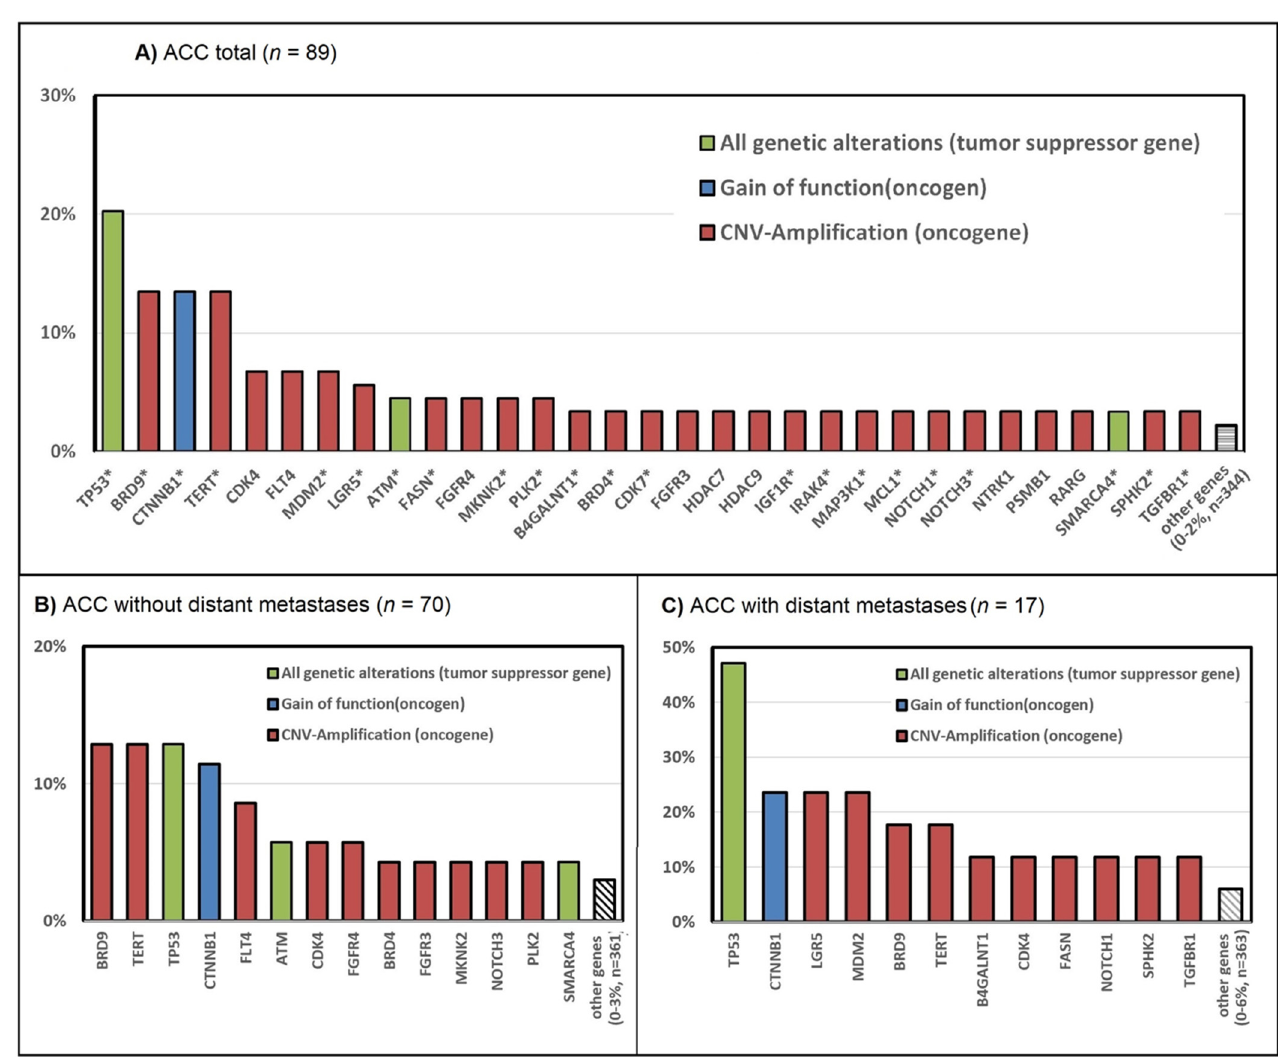
Figure 2. Target genes with FDA-approved drugs and drugs in clinical trials ( A ) depicts genetic alterations of TCGA (x-axis), which are targeted by FDA-approved drugs or drugs currently being tested in clinical trials (*). On the y axis, the frequency of these alterations can be read. Gain-of- function alterations are depicted in blue, and CNV amplifications, in red. Green is used for tumor suppressor genes; ( B , C ) depict a subgroup analysis of non-metastatic ACC ( B ) versus metastatic ACC ( C ). In 2 of 89 patients, tumor stage was not documented ( n = 87).